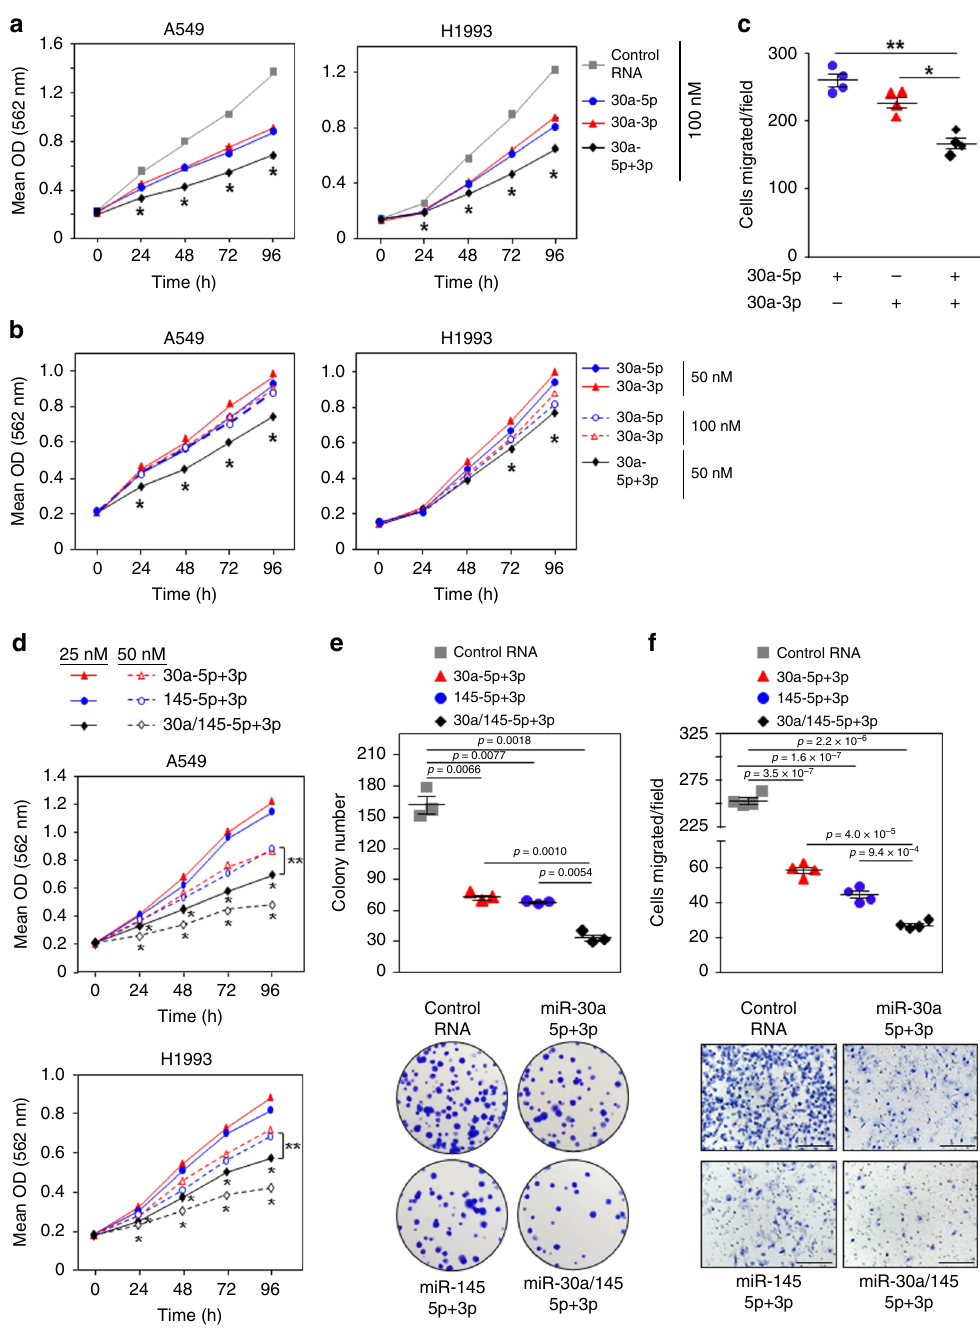
Fig. 6 Cooperation of all four strands of miR-30a and miR-145 in cancer cell growth and movement. Lung adenocarcinoma lines transfected with miR- 30a-5p, miR-30a-3p, miR-145-5p, and/or miR-145-3p miRNA mimic, or control RNA at the indicated concentrations. Control RNA was also added to equalize the total amount of RNA transfected. a , b , d MTT assays performed at intervals, in quadruplicate. Each assay was performed 2 – 4 independent times for both cell lines and one representative experiment is shown. For a , A549 *P < 6.18 × 10 − 5 , H1993 *P < 2.36 × 10 − 2 (comparing 5p + 3p to 5p or 3p alone); for b , A549 *P < 9.21 × 10 − 6 , H1993 *P < 1.91 × 10 − 2 (comparing 5p + 3p to 5p or 3p alone at both concentrations); for d , A549 * P < 1.69 × 10 − 4 and ** P < 7.02 × 10 − 5 , H1993 * P < 4.27 × 10 − 4 and ** P < 2.82 × 10 − 3 (*, comparing 30a-5p/3p + 145-5p/3p to 30a-5p/3p or 145-5p/3p at both concentrations and **, comparing 25 nM 30a-5p/3p + 145-5p/3p to 50 nM 30a-5p/3p or 145-5p/3p); two-tailed t -tests. c , f Transwell migration assays were performed 2 ( c ) or 4 ( f ) independent times and results from one representative experiment are shown for each. For c , * P = 2.3 × 10 − 3 and ** P = 2.0 × 10 − 4 ; for f , P -values indicated; two-tailed t -tests. Representative images shown in f (x10 magni fi cation; scale bars, 200 μ m). e Colony formation assays were performed two independent times, in triplicate, and a representative experiment and images (no magni fi cation) are shown. P -values indicated; two-tailed t - tests. Data are presented as mean values± SEM; error bars are within the symbols in a , b , and d . Source data are provided as a Source Data fi